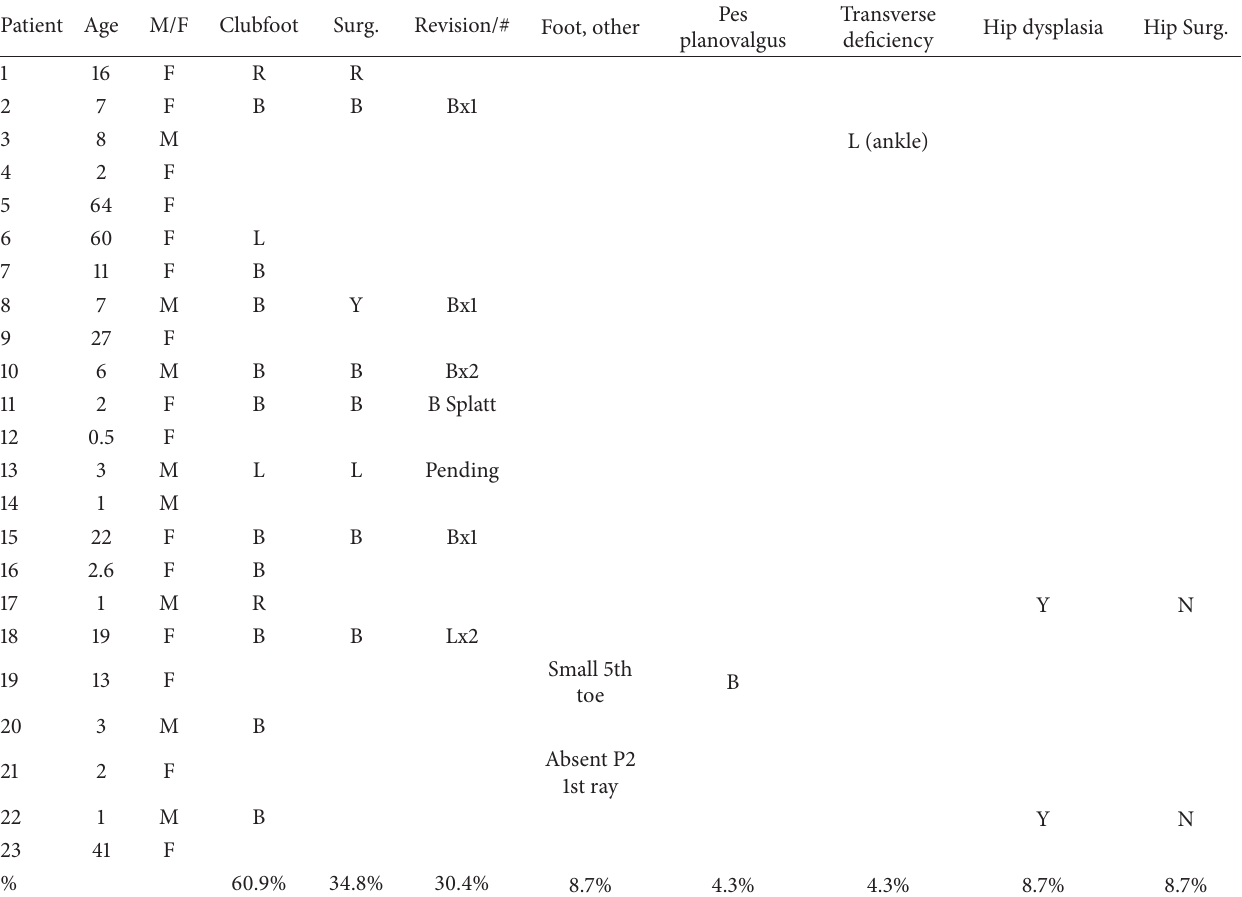
Table 1: Patient series results.